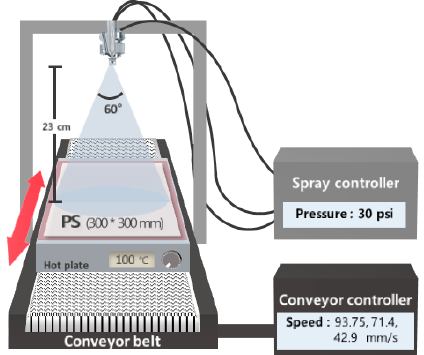
Figure 1. Schematic of large-area spray coating.